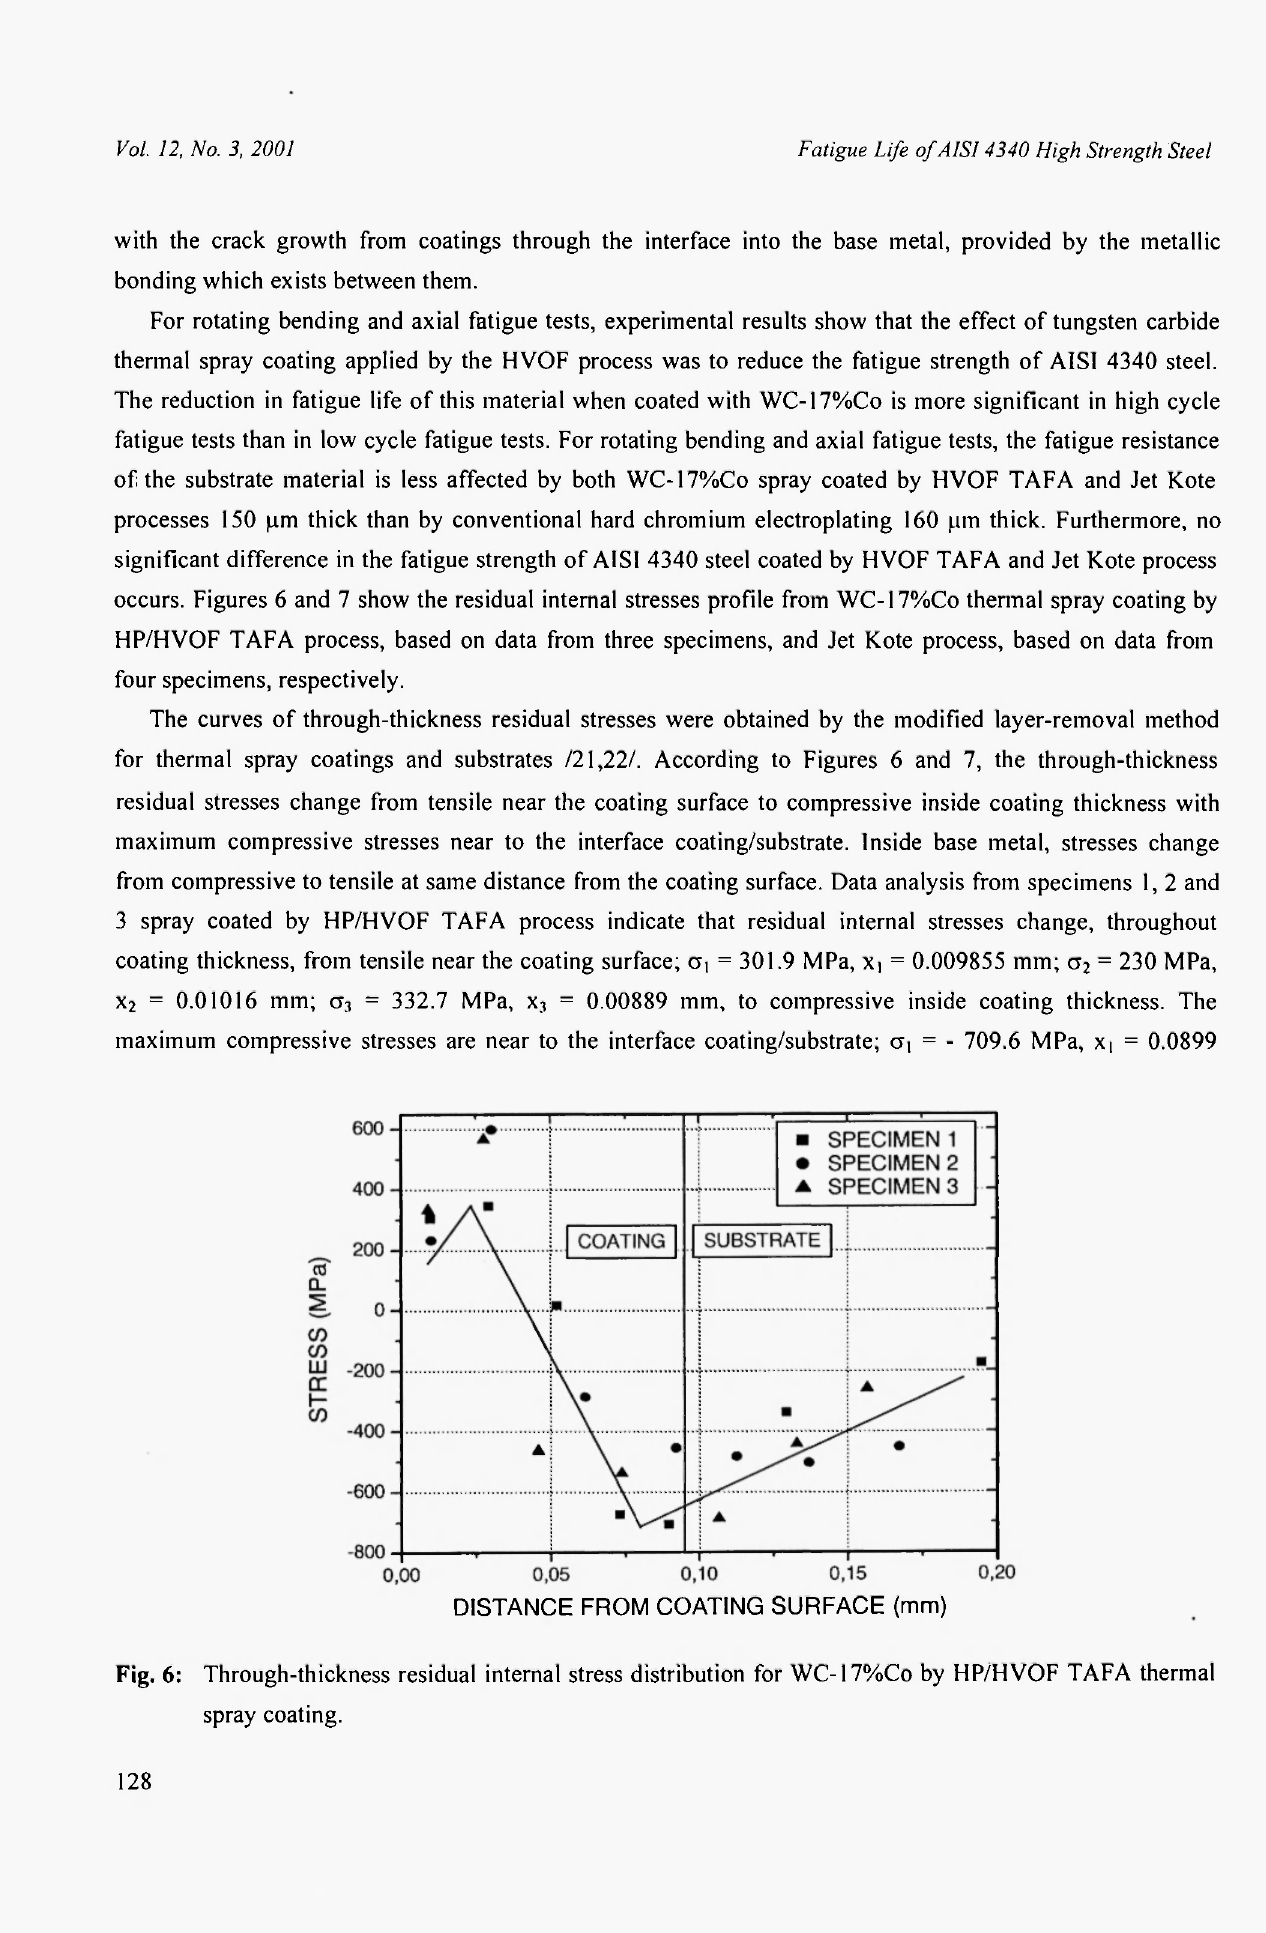
Fig. 6: Through-thickness residual internal stress distribution for WC-17%Co by HP/HVOF TAFA thermal spray